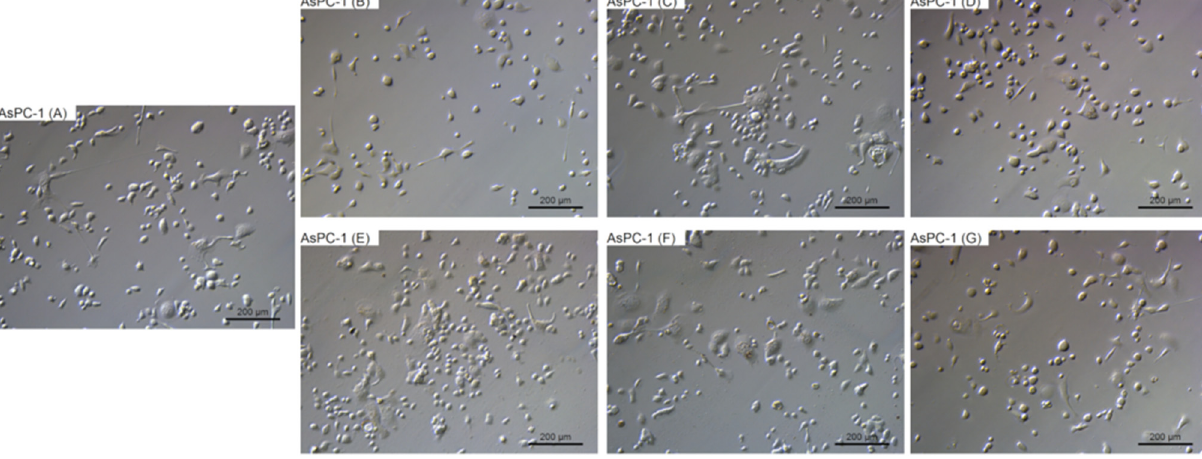
Figure 7. Morphological characterization of the AsPC-1 human pancreatic adenocarcinoma cell line. The cells were treated with metallic NPs at a concentration of 1 mg/L and carbon-based nanomaterials at a concentration of 10 mg/L. The incubation period lasted for 24 h. ( A ) control were treated with ultrapure water, ( B ) cells were treated with Ag, ( C ) cells were treated with Au, ( D ) cells were treated with Pt, ( E ) cells were treated with GO, ( F ) cells were treated with ND, and ( G ) cells were treated with C 60 (OH) 40 .